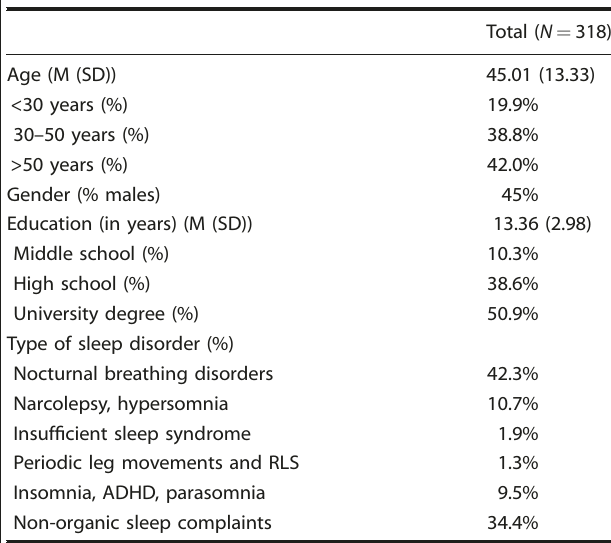
Table 1. Sample characteristics.